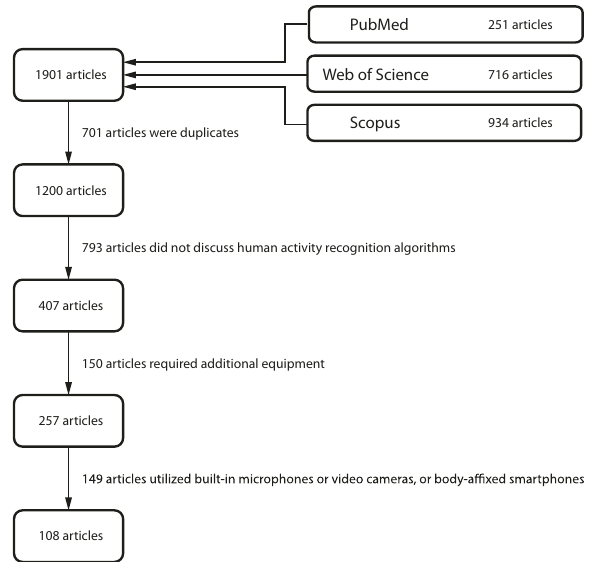
Fig. 2 PRISMA diagram of the literature search process. The search was conducted in PubMed, Scopus, and Web of Science databases and included full-length peer-reviewed articles written in English. The search was carried out on January 2,